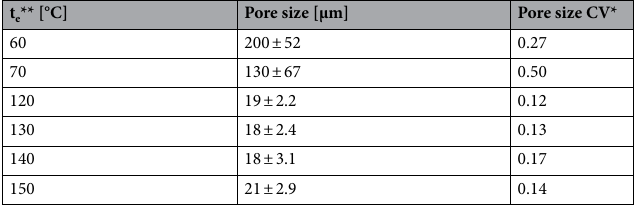
Table 1. Pore size of the present porous PDMS layer fabricated at WMR = 0.5 for varying t e . *Coefficient of variance (CV) = standard deviation / average. **Toluene and ethanol solvent mixture evaporation temperature (t e ), effective for citric acid crystal